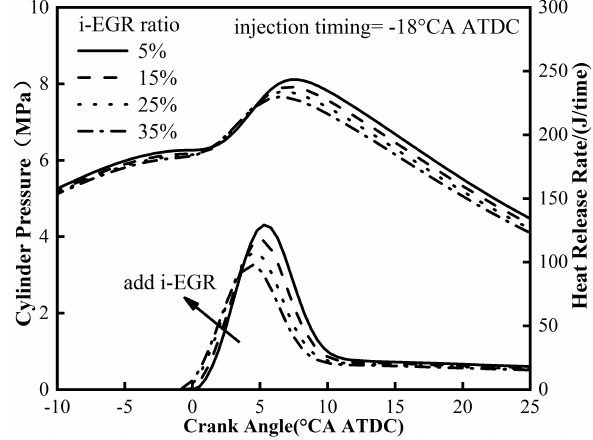
Fig. 14 Effect of i-EGR ratio and e-EGR ratio on cylinder pressure and heat release rate.